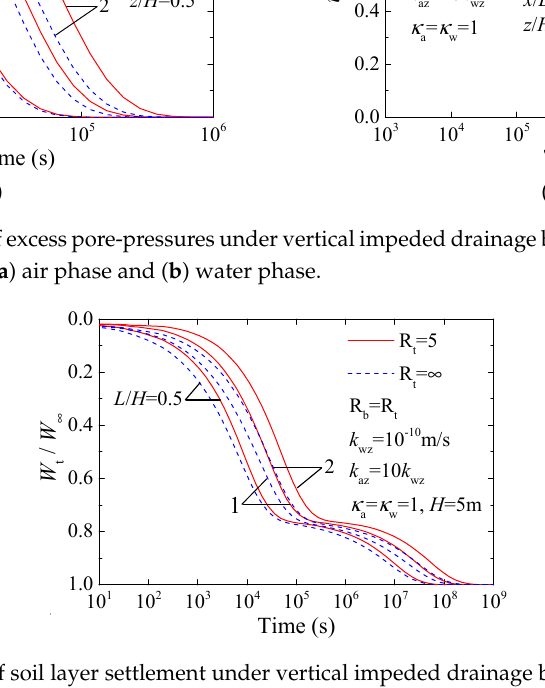
Figure 14. Variations of soil layer settlement under vertical impeded drainage boundary with different spacing-depth ratios.